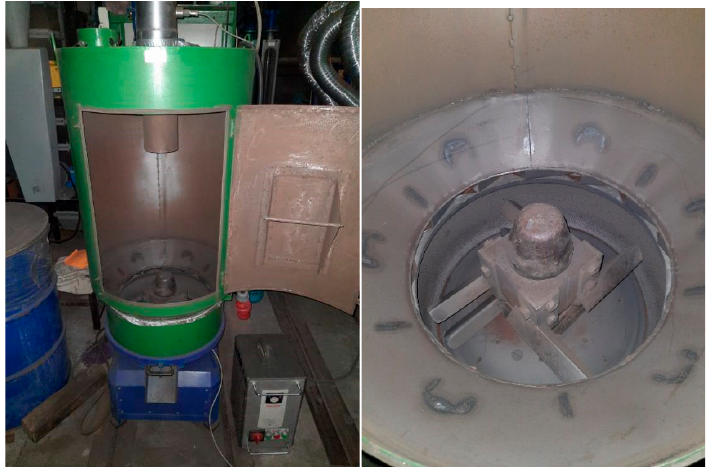
Figure 1. View of the experimental RD-6 rotor regenerator equipped with a dust extraction system generated in the matrix abrasive and crushing process.